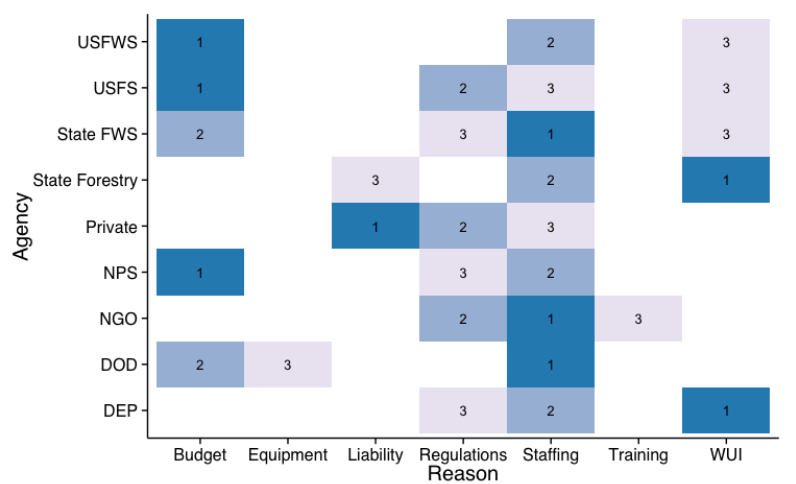
Figure 2. Ranking of perceived non-weather impediments to the use of prescribed fire by most well-represented land management entity (1 is the highest, or most important, ranking). Note: Categories with fewer than 15 respondents were not